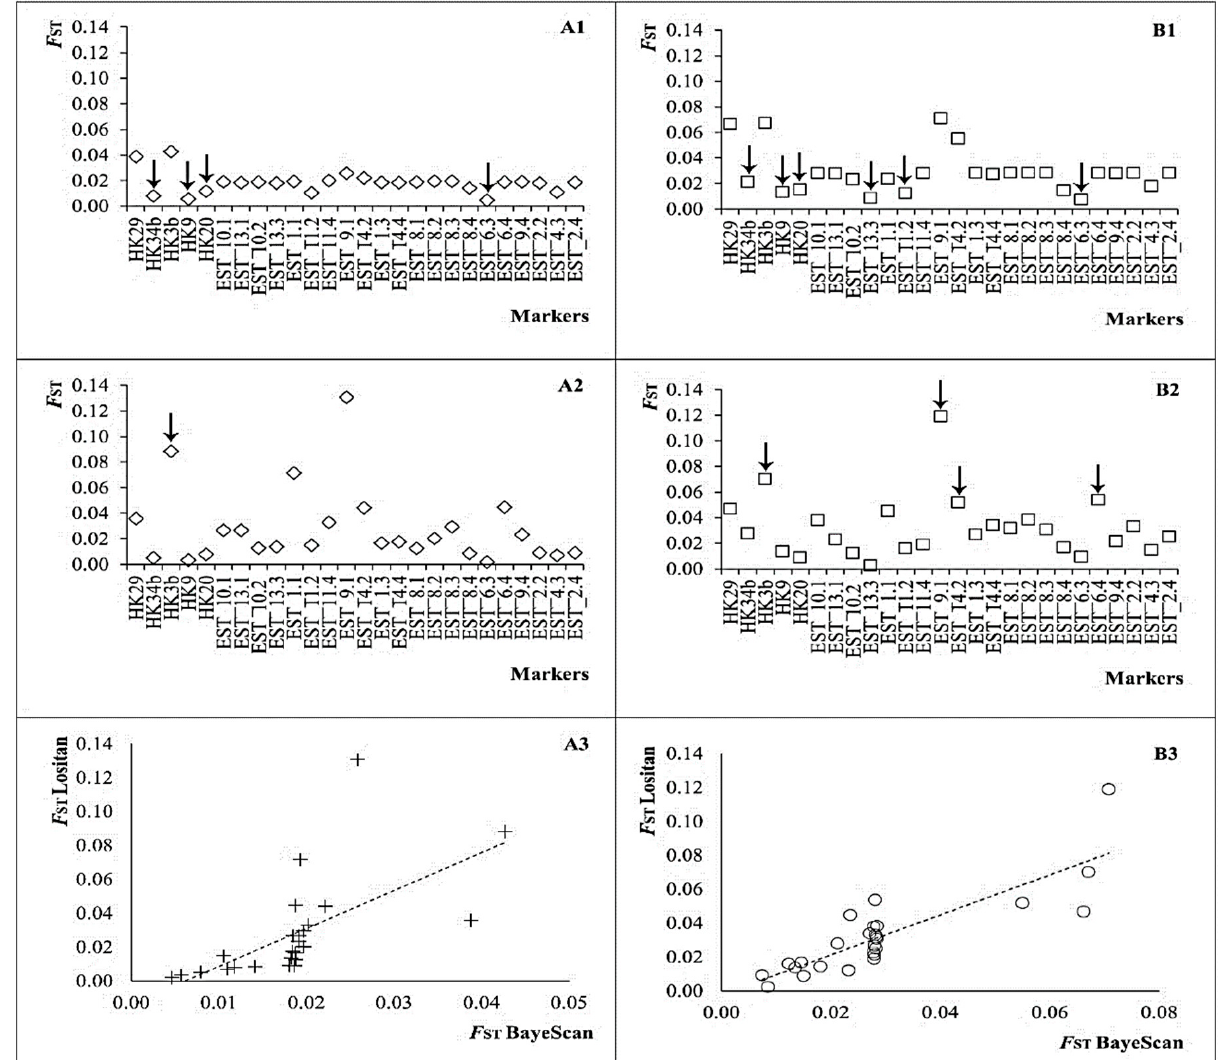
Figure 2. Interpopulation fixation index F ST per microsatellite calculated between Atlantic and Mediterranean hake subpopulations (panel ( A ): ( A1 ), F ST from BAYESCAN; ( A2 ), F ST from LOSITAN; ( A3 ), correlation between F ST estimated with BAYESCAN and LOSITAN ( Y = 2.241 X − 0.0138; R 2 = 0.400; F = 16.006; p = 0.001)) and among five regions (panel ( B ): ( B1 ), F ST from BAYESCAN; ( B2 ), F ST from LOSITAN; ( B3 ), correlation between F ST estimated with BAYESCAN and LOSITAN ( Y = 1.1806 X − 0.0024; R 2 = 0.714; F = 59.755; p < 0.001)). Arrows indicate loci with significant departure from neutrality (see Table